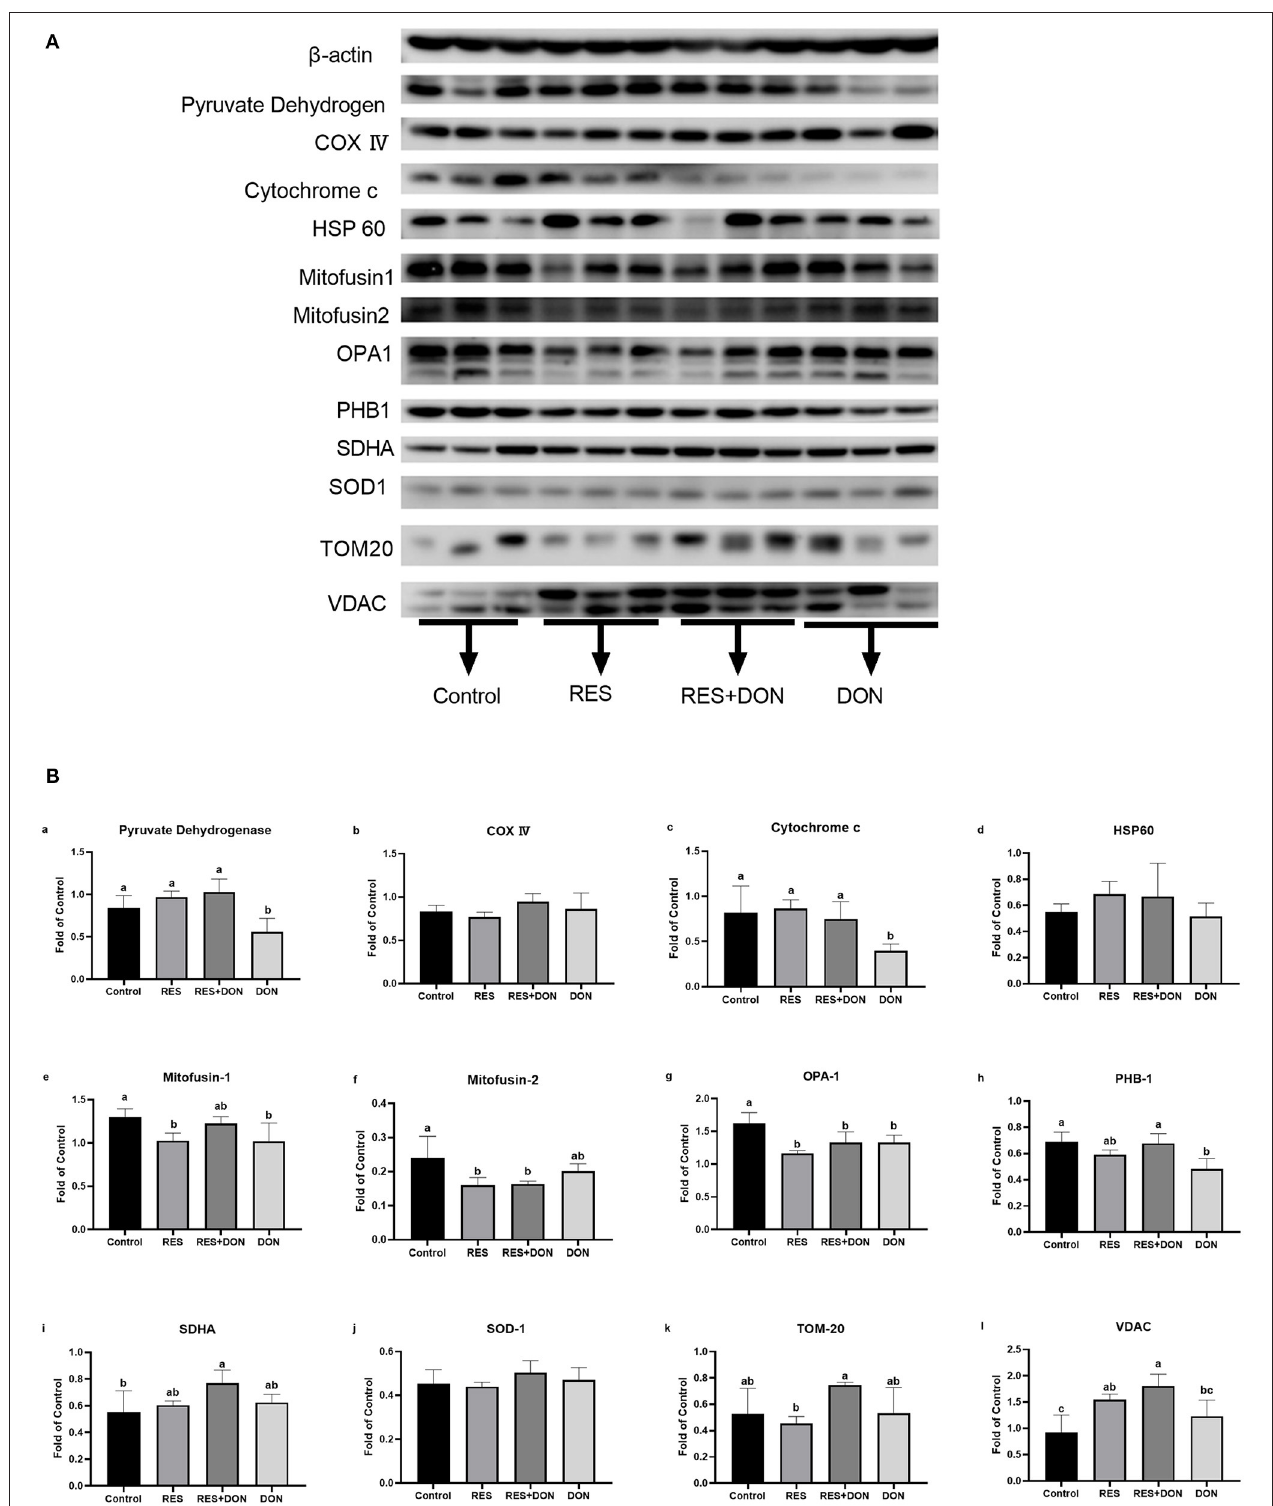
FIGURE 3 | Dietary supplementation with RES affects the expression of mitochondrial related genes. Cells were treated with 0 (NC) or 0.5 µ mol/L DON and 0 or 15 µ M RES, respectively. Data were expressed as means ± SEM of at least three independent experiments. (A,B) Values with different letters are significantly different ( P <